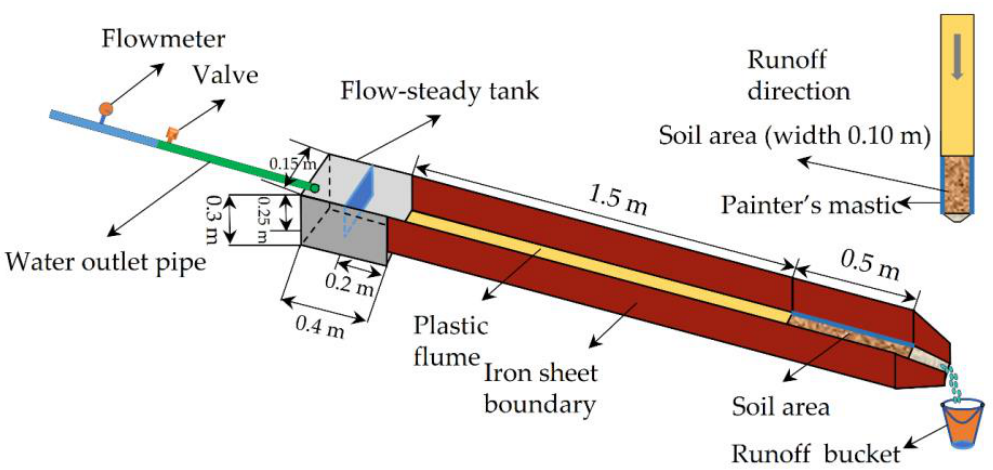
Figure 2. Skitch of scouring flume for determining soil erosion resistance of gully heads.